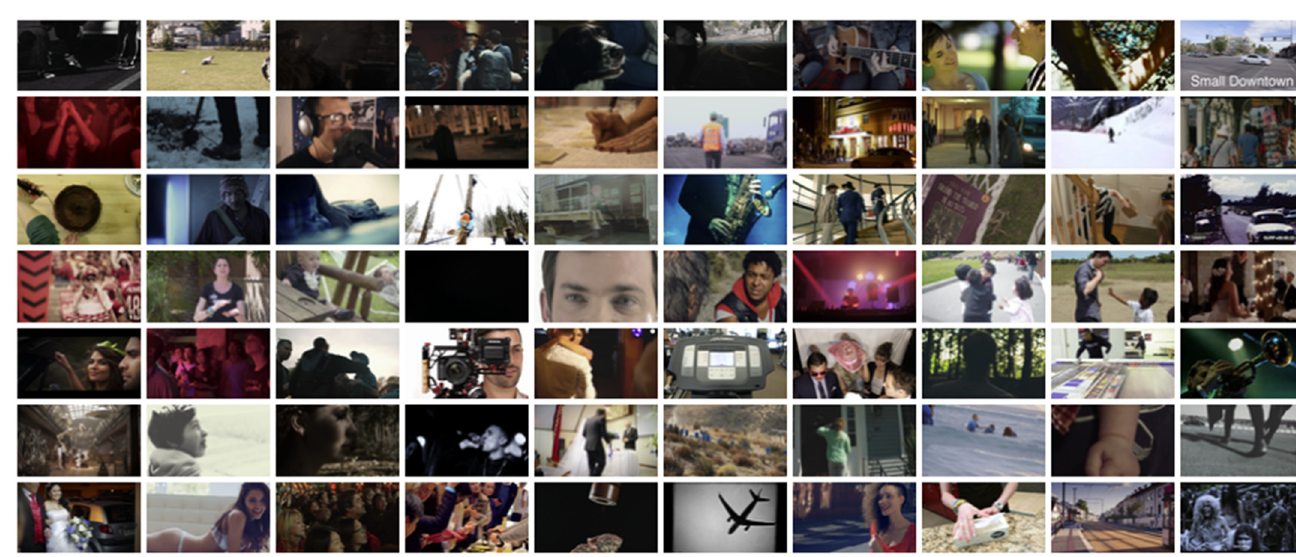
Figure 13. Vimeo-90K training and test dataset.